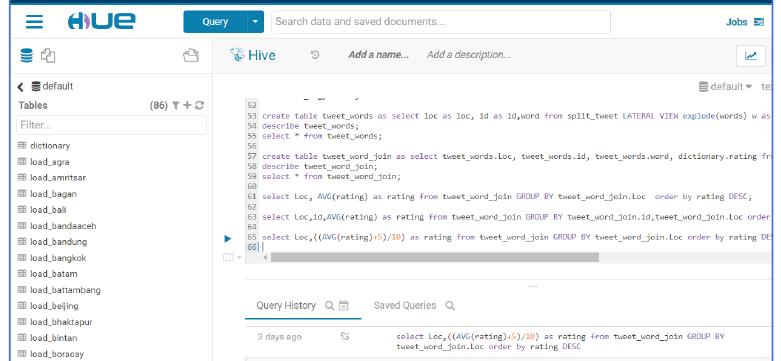
Figure 19. Rapid Miner Radoop for direct analysis using Hadoop storage of tweets.